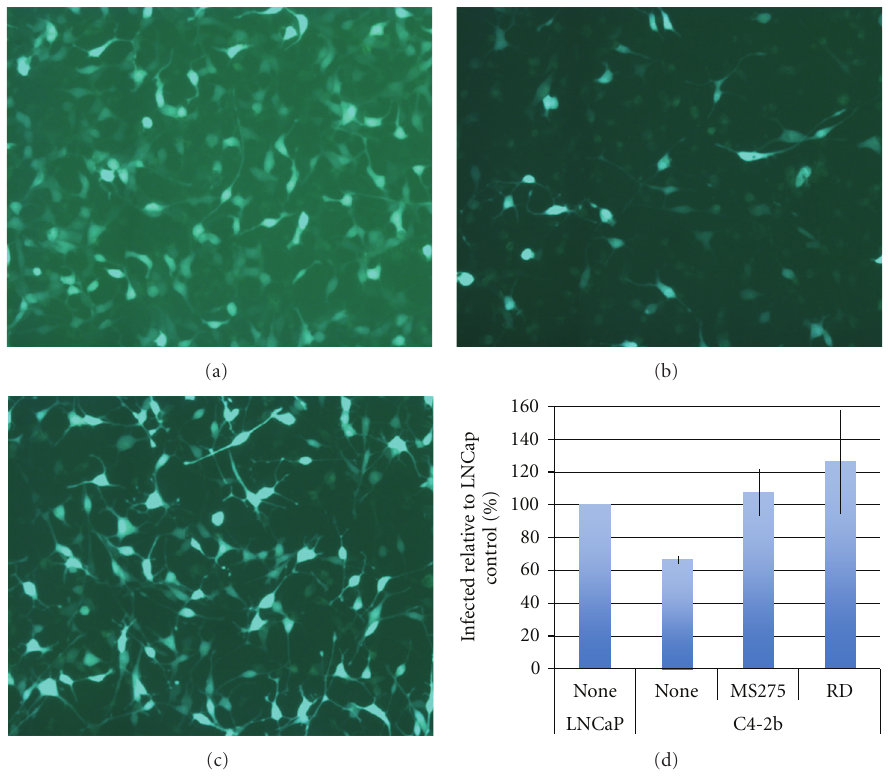
Figure 4: Analysis of GFP expression by fluorescence microscopy and quantification by flow cytometry. LNCaP (a) and C4-2b (b, c) were plated overnight and exposed to 10 MOI AdGFP in the absence (a, b) or presence of (c) 10 µ M MS-275. Fluorescent images were collected using identical camera settings 48 hrs after viral transduction (magnification = 200x). (d) Quantification of GFP-positive cells by flow cytometry 24hrs after viral transduction in the absence or presence of 100 ng/mL romidepsin or 10 µ M MS-275. Data shown are the mean ± SD from three experiments.